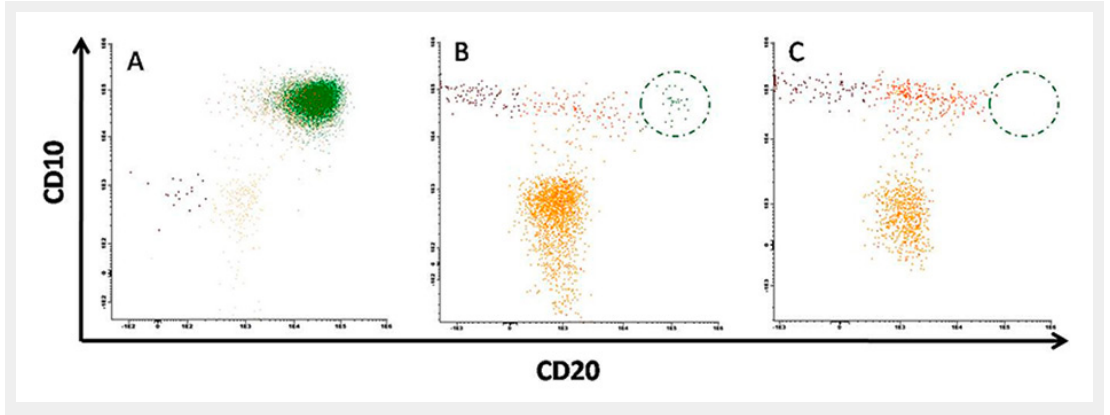
Minimal residual disease detection using flow cytometry. A. Patient diagnosed with a massive B-lineage acute lymphoblastic leukaemia clone characterised by CD10/CD20 double positivity (green) and bone marrow dysplasia. B. Same patient after chemotherapy. Bone marrow regeneration is confirmed by a high number of progenitors (yellow) and normal B cell differentiation is resumed (brown to orange). However residual disease was also detected (green). C. Normal bone marrow from healthy donor. 10 6 total events were acquired in each case.